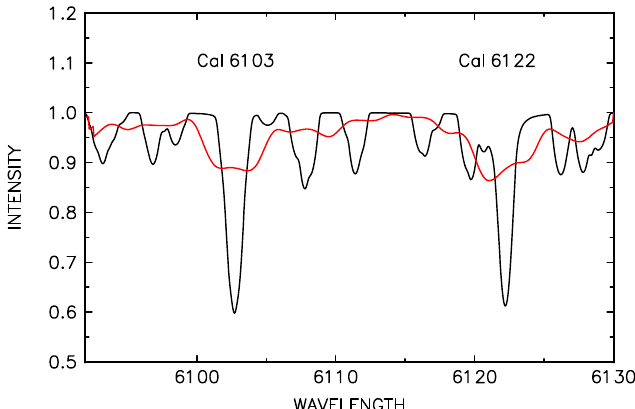
Figure 4. A part of the synthetic spectrum of RW Aur in the vicinity of the Ca I 6103 and 6122 Å lines in the bright state (black) and the deep minimum